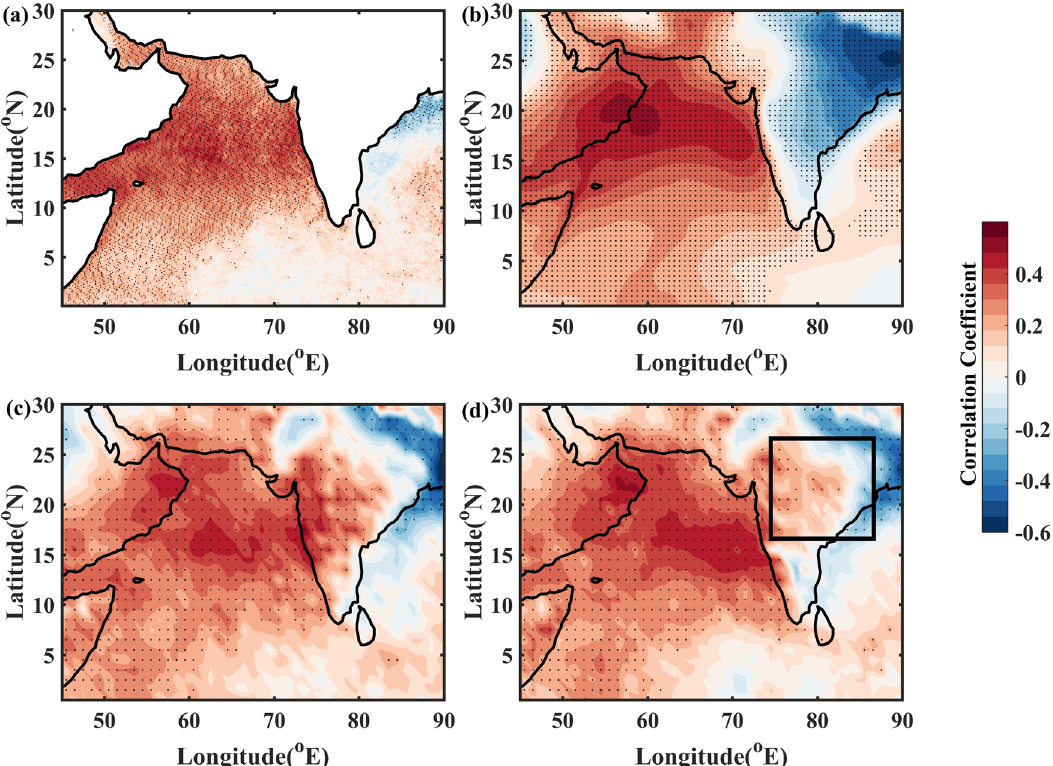
Fig. 1 Observed spatial correlation between AS aerosols and CI rainfall. The spatial pattern of the correlation coef fi cient between weekly mean AOD over AS and rain over CI (region inside the box) for a AVHRR(1981 – 2013), b MERRA-2(1981 – 2013), c MODIS-Aqua (2002 – 2013) and d MODIS-Terra (2000 – 2013). The black dots represent the statistical signi fi cance at 95% con fi dence